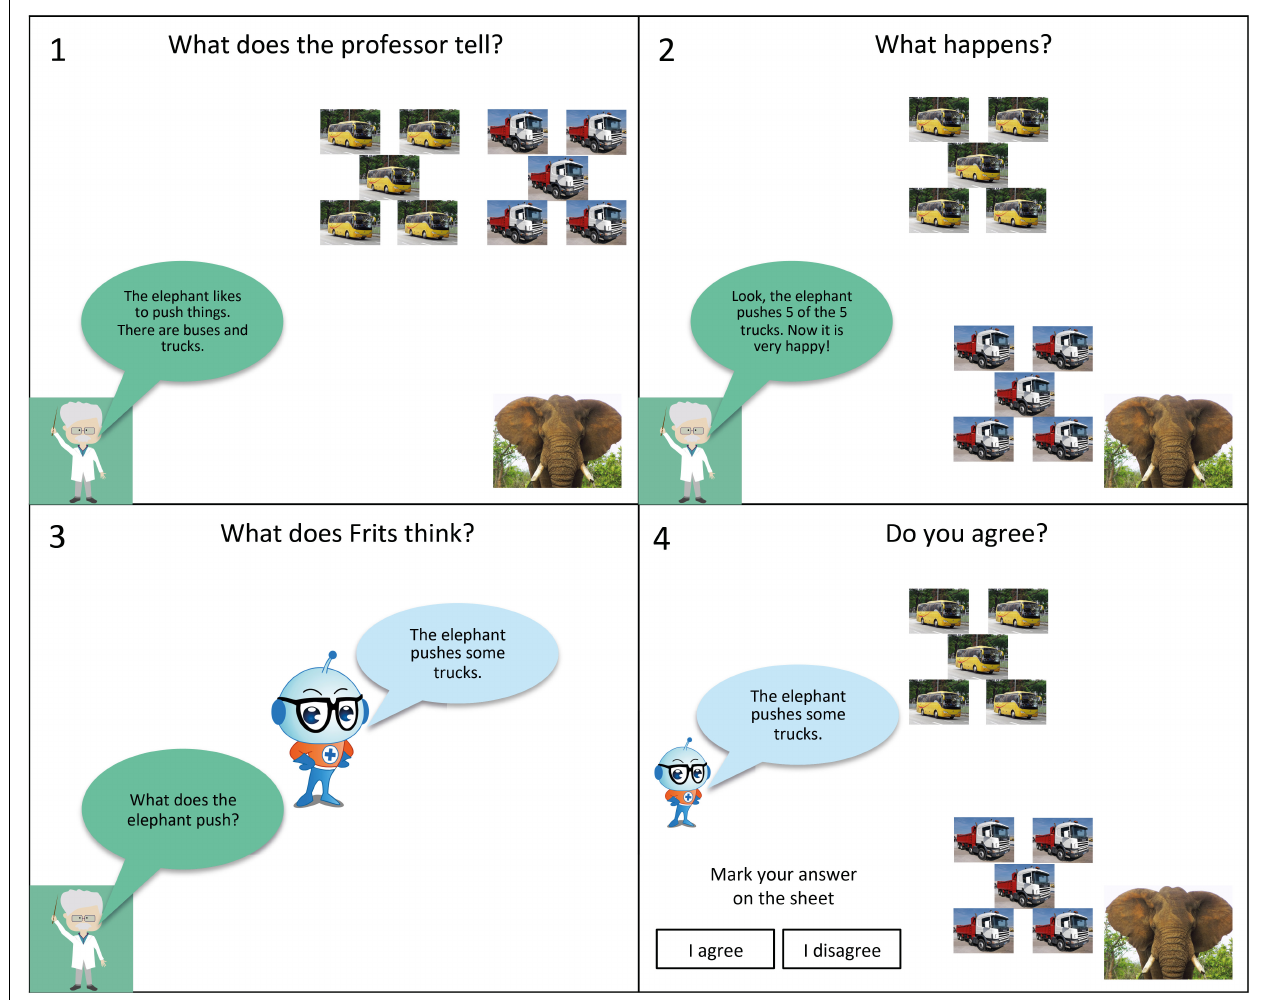
FIGURE 1 | Example of presentation procedure for a story in the scalar underinformative condition in Experiment